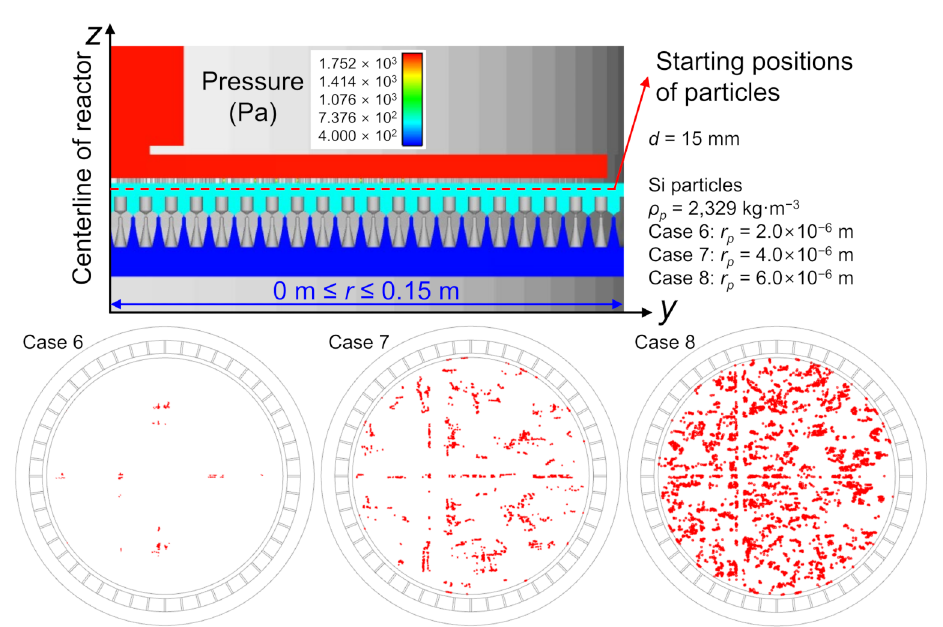
Figure 5. Starting positions of inertial particles are indicated. The spatial variation in the gas pressure ( p g , Pa) is plotted together for Case 3. Final positions of particles deposited on the heater surface depicted for Case 6 ( r p = 2.0 × 10 − 6 m, ρ p = 2329 kg · m − 3 , d = 15 mm), Case 7 ( r p = 4.0 × 10 − 6 m,